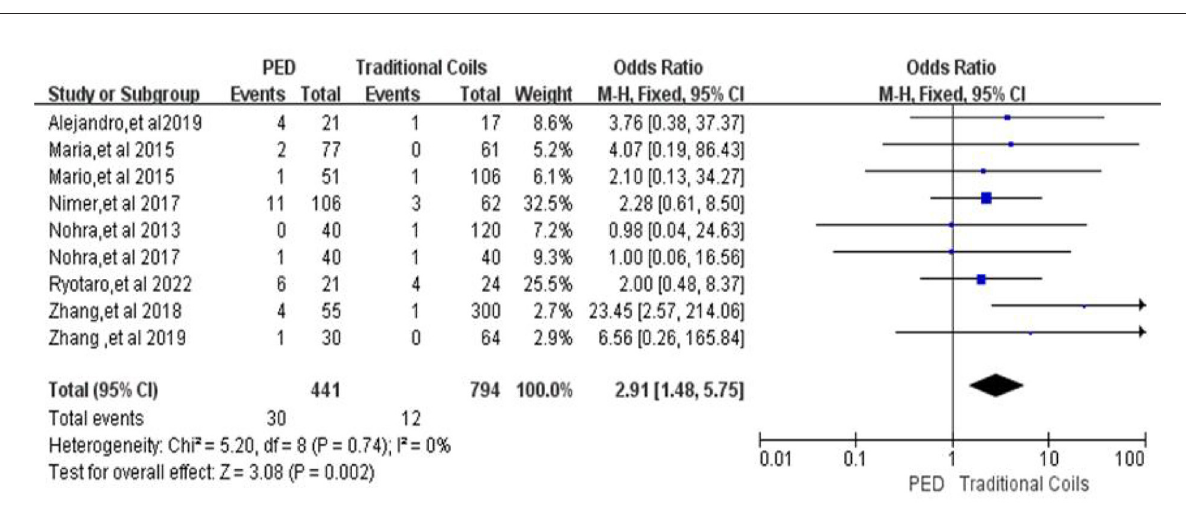
FIGURE4 Forest plot and meta-analysis of other procedure-related